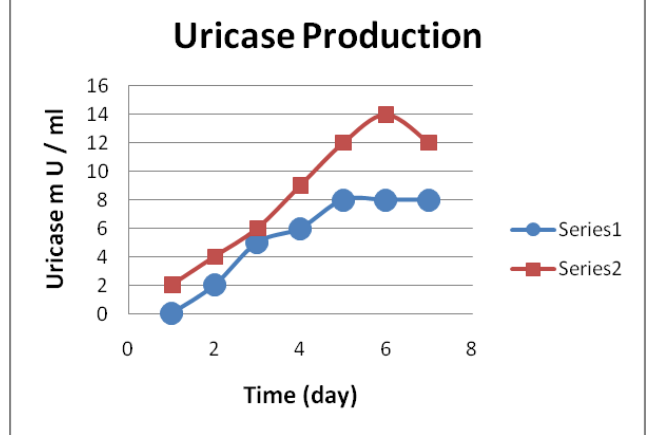
Figure 9. Comparison of uric acid production in presence and absence of uric acid (series- 1 in absence of uric acid , series 2- in presence of uric